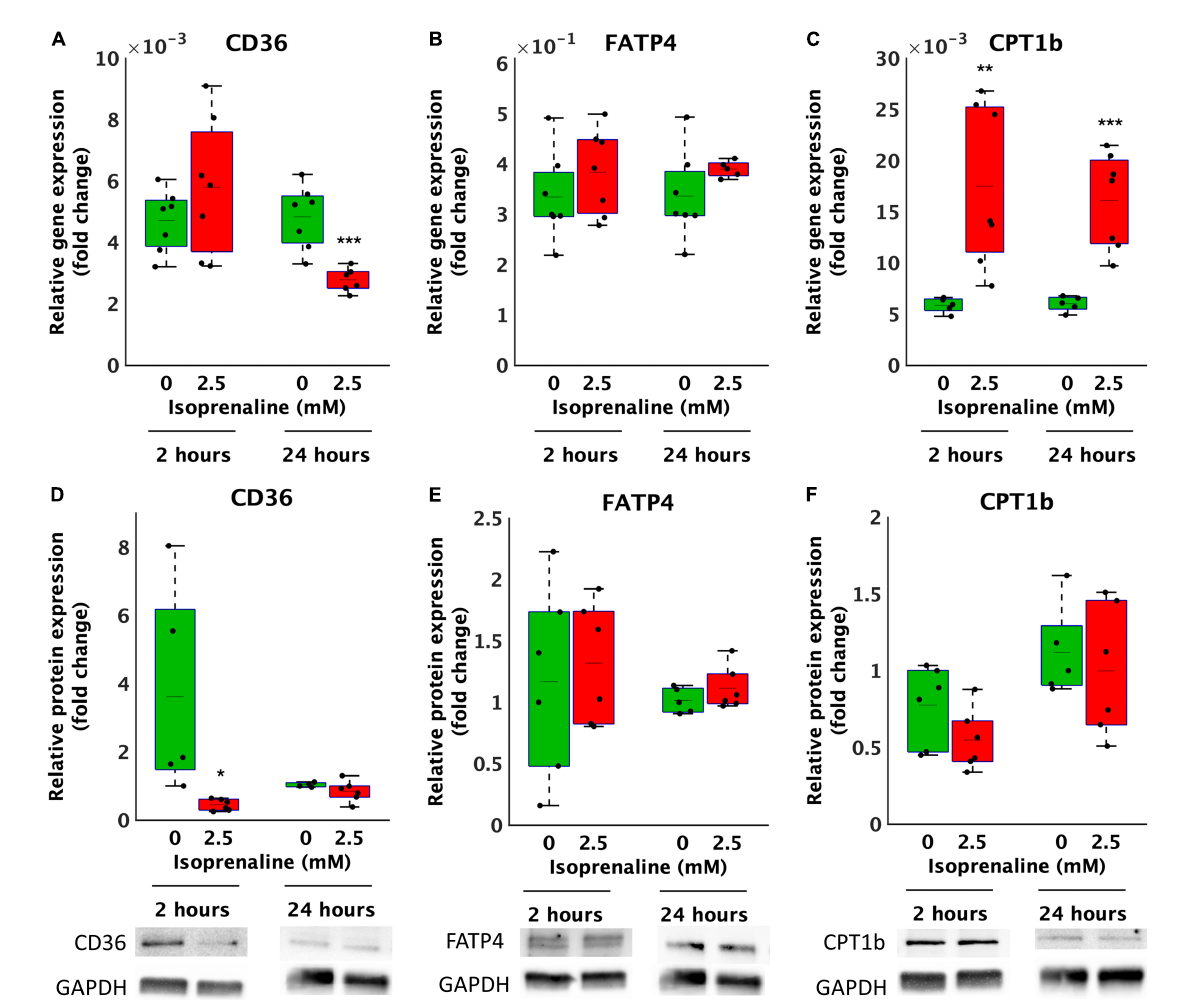
FIGURE3 Altered gene and protein expression of lipid transporters in HL-1 cardiomyocytes exposed to isoprenaline. (A–C) qPCR analysis of HL-1 cardiomyocytes exposed to 0.0 mM and 2.5 mM levels of ISO for 2 h (green boxes) and 24 h (red boxes). Statistical significance was assessed using a two-tailed t -test. N = 6 replicates per group. All values shown for the PCR analyses are relative to the housekeeping gene TBP and GUSB. n = 6 replicates per group, 3 technical replicates, (D–F) Western blot analyses of HL-1 cardiomyocytes exposed to 0.0 mM and 2.5 mM levels of ISO for 2 h (green boxes) and 24 h (red boxes). Statistical significance was assessed using a two-tailed t -test. All values shown for the PCR analyses are relative to the loading control GAPDH. n = 6 replicates per group, 2 technical